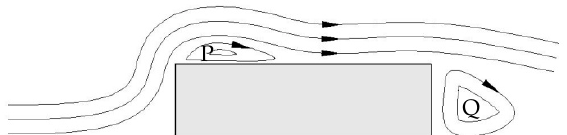
Figure 14. A steady flow passing an obstacle with leading and trailing rectangular corners, and standing vortexes,P and Q, are generated as a result of the boundary layer separation.